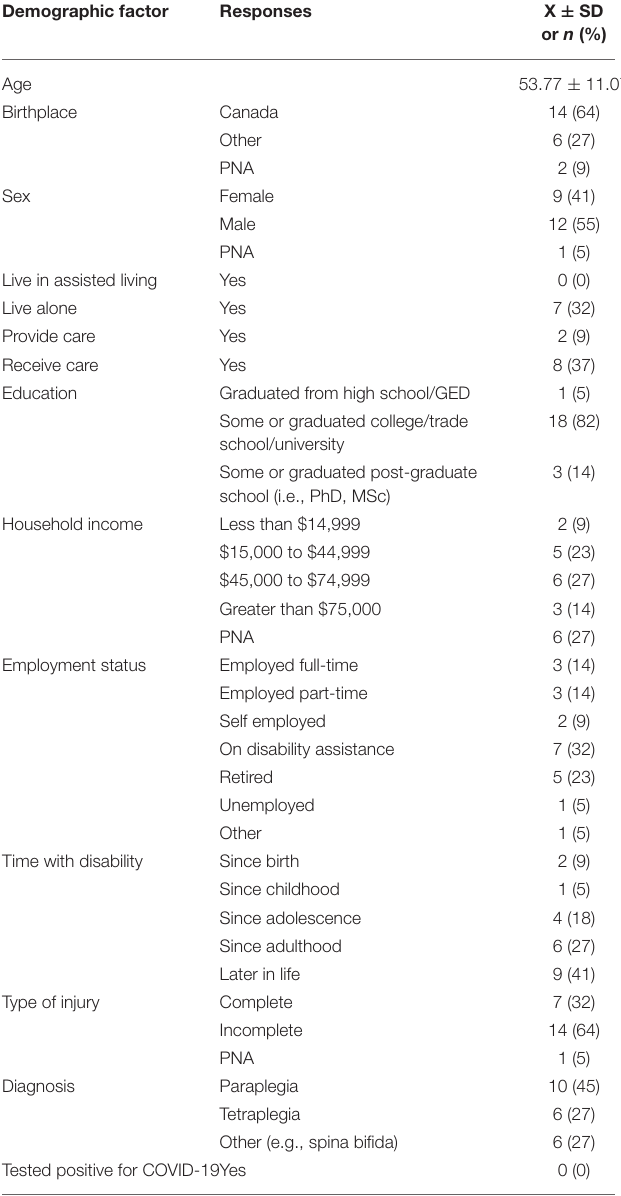
TABLE 2 | Sample demographic information ( N = 22).